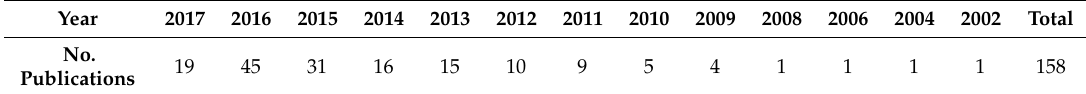
Table 1. Distribution of the reviewed papers during years.